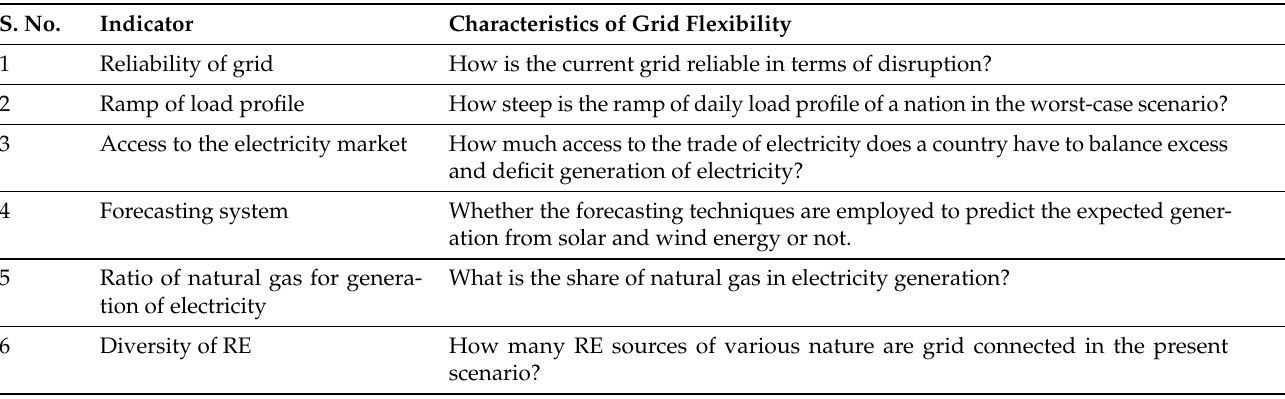
Table 2. Summary of indicators utilized for characterizing the grid